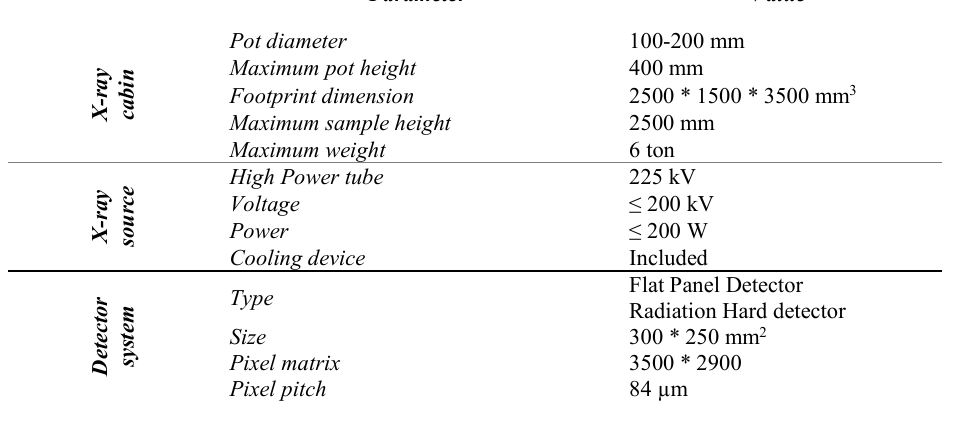
Table 1. Technical specifications of the X-Ray CT system.